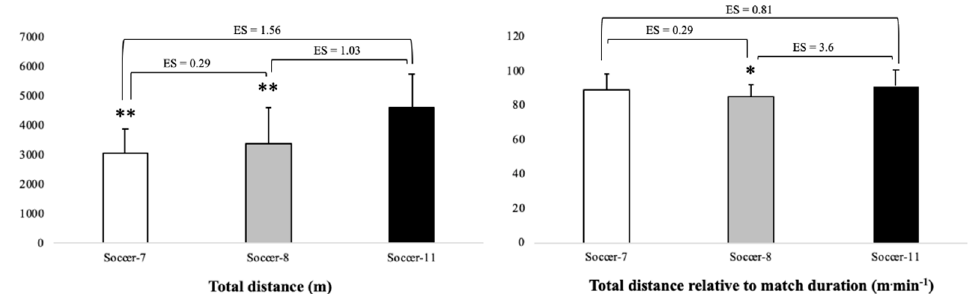
Figure 1. Total distance and total distance relative to match duration during Soccer-7, Soccer-8, and Soccer-11 official matches. ES: effect size; * and **: Significant differences versus Soccer-11 ( p < 0.05 and p < 0.01, respectively).